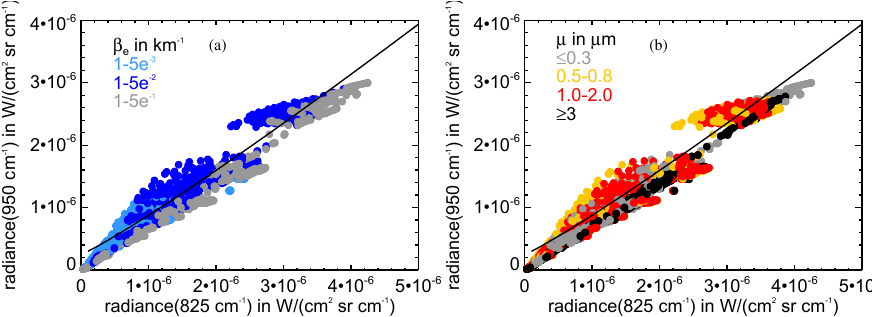
Figure 11. (a) Extinction coefficient and (b) radius dependencies for volcanic ash clouds at 18km altitude. The black line is the ash detection threshold.